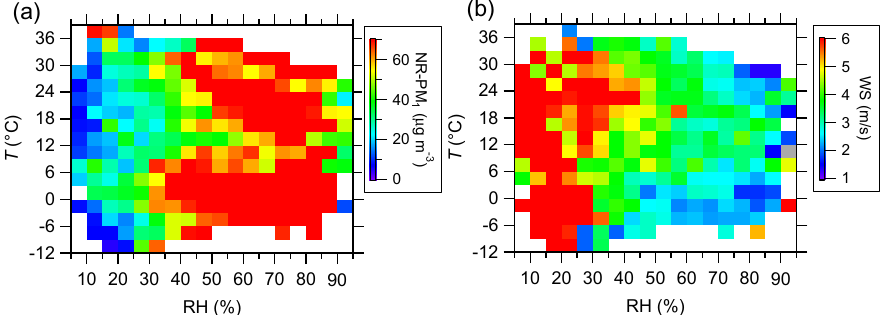
Figure 9. RH/ T dependence of (a) NR-PM 1 mass concentration and (b) WS for a whole year. The data are grouped into grids with increments of RH and T being 5% and 3 ◦ C, respectively. Grid cells with a number of data points fewer than 10 are excluded.